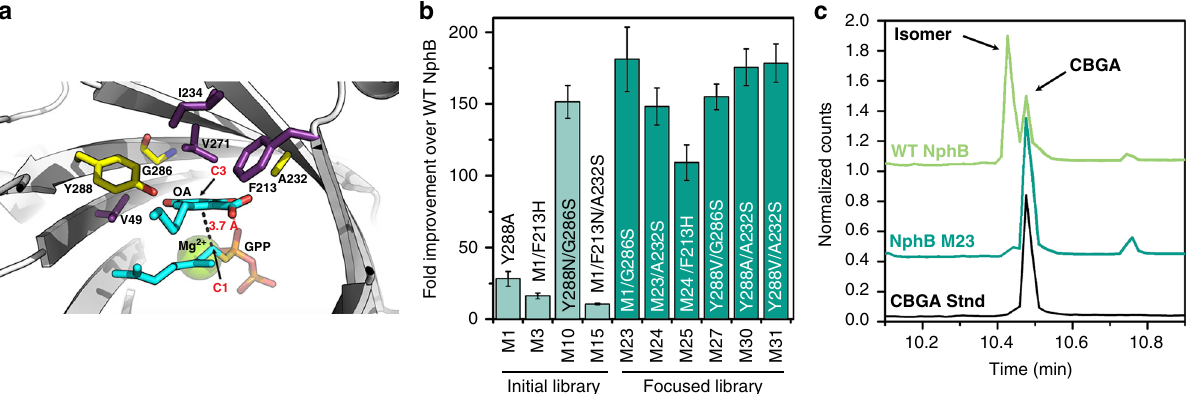
Fig. 3 Engineering NphB to improve CBGA production. a A model of olivetolate in the active site of WT NphB (1ZB6). Residues highlighted in yellow and purple were allowed to vary during the design process. The residues in yellow had the largest effects on activity with OA and were the positions targeted in the focused library. b The results of an activity assay to determine the approximate activity of NphB mutants with olivetolate as the substrate. The fold improvement is an average of triplicate reactions with GPP (2.5 mM), olivetolate (5 mM), MgCl 2 (5 mM), and 1 mg/mL of WT or mutant NphB (biological replicates, n = 3, error range is standard deviation). c GC – MS chromatograms of the full pathway reaction products using M23 or WT NphB compared to a CBGA standard. Source data for Fig. 3b, c are provided as a Source Data fi